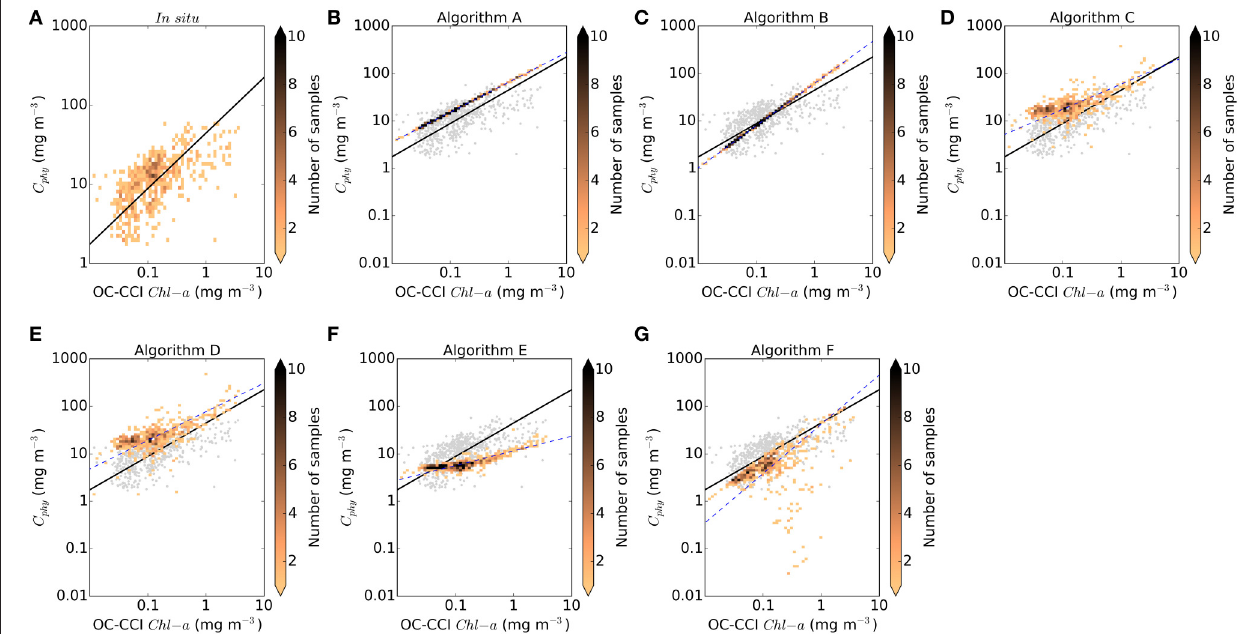
FIGURE 4 | Density plot of covariance between OC-CCI standard chlorophyll product and C phy from the match-up database ( N = 557). (A) In situ C phy , (B) Sathyendranath et al. (2009), (C) Marañón et al. (2014), (D) Behrenfeld et al. (2005), (E) Martínez-Vicente et al. (2013) modified, (F) Kostadinov et al. (2009, 2016), (G) Roy et al. (2017). Blue dashed line is the Type II linear regression (Reduced Major Axis) fitted to the log 10 converted data. Black solid line is the regression line between chlorophyll and in situ for comparison with the regressions by the algorithms. For comparison, data in (A) are repeated (gray) in the other panels.